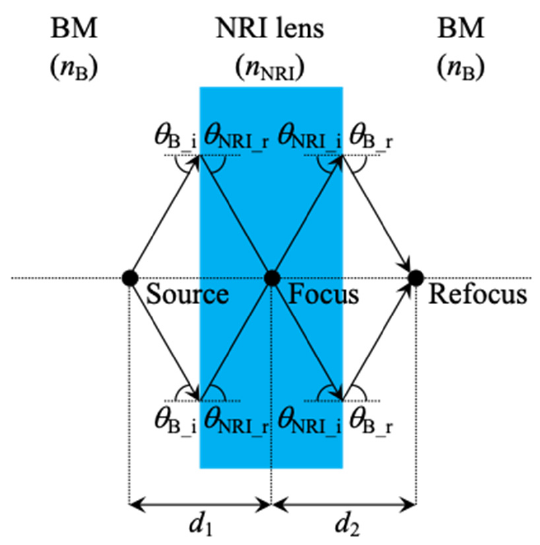
Figure 3. The concept of an NRI acoustic lens. | n NRI | = n B , θ B_i = | θ NRI_r | = θ NRI_i = | θ B_r |, d 2 = d 1 are assumed in this figure.